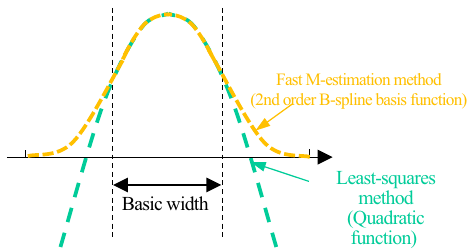
Figure 1. Loss function in the robust